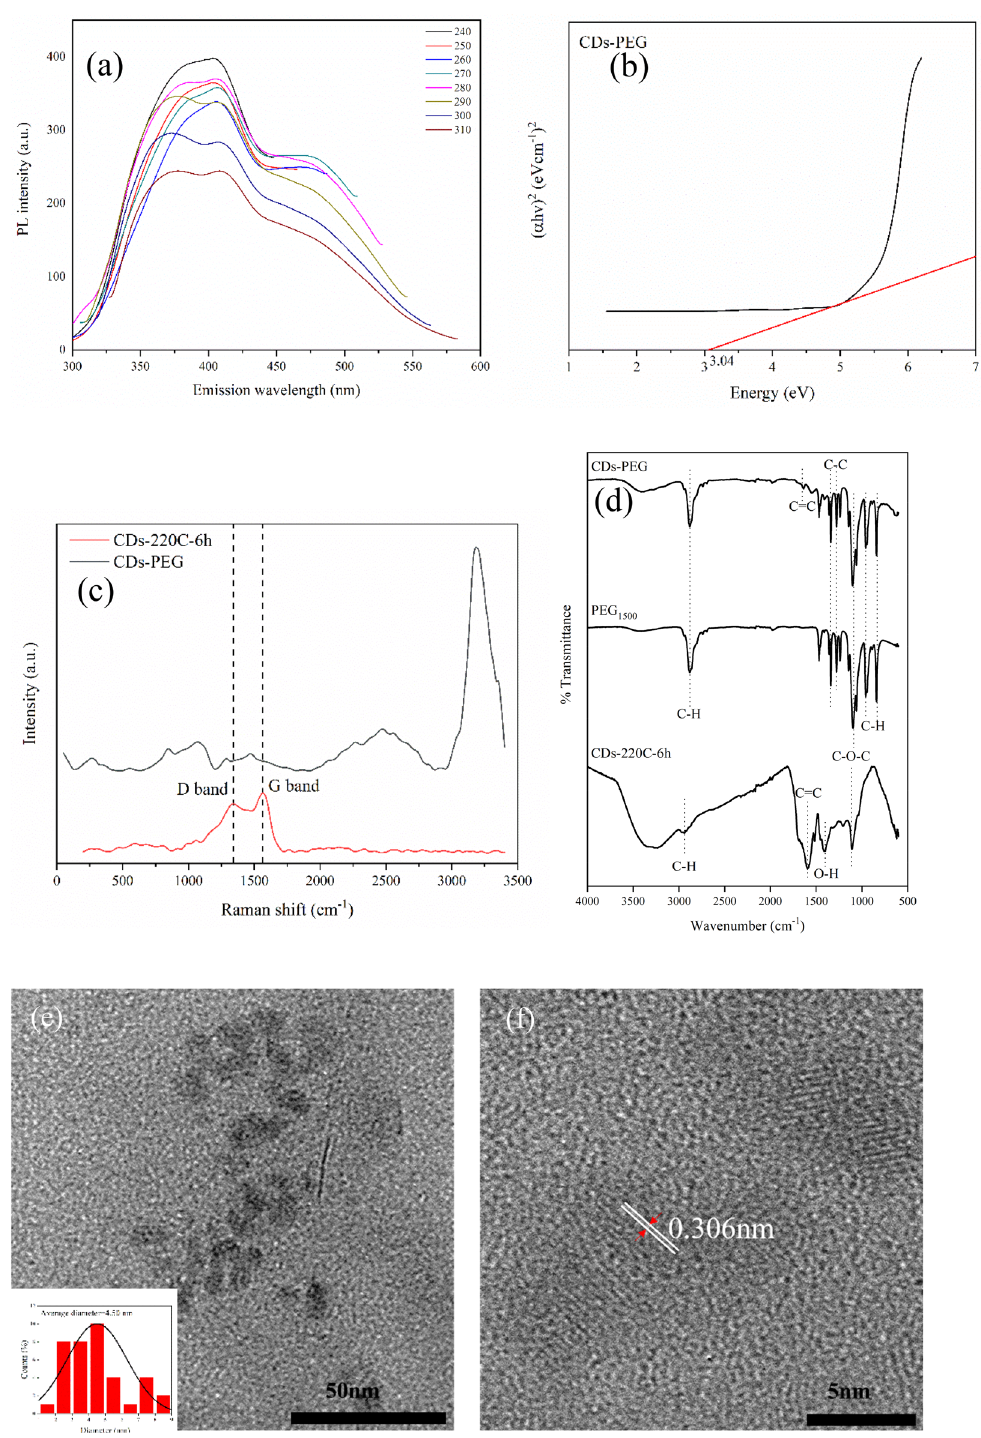
Figure 5. CDs-PEG characterization ( a ) PL spectra of CDs-PEG synthesized by hydrothermal carbonization at 220 °C for 6 h, ( b ) Energy band gap of CDs-PEG, ( c ) Raman spectroscopy of CDs-PEG and CDs-220C-6h, ( d ) FT-IR spectra of CDs-220C-6h, neat PEG1500 and CDs-PEG, ( e ) HR-TEM images with size distribution histogram inset, ( f ) HR-TEM image of a typical CDs, showing the solidified graphite liner core of